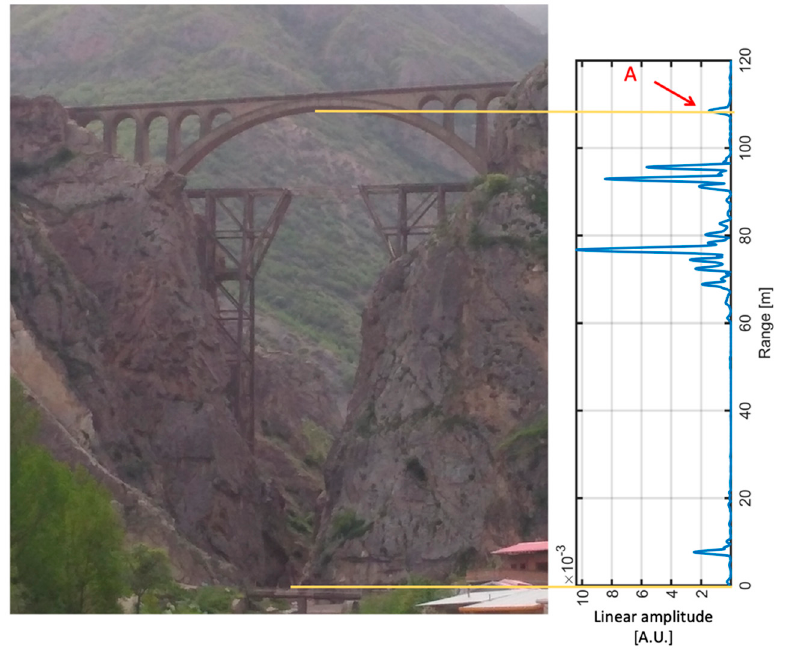
Figure 7. Picture of the Veresk Bridge and amplitude radar plot.